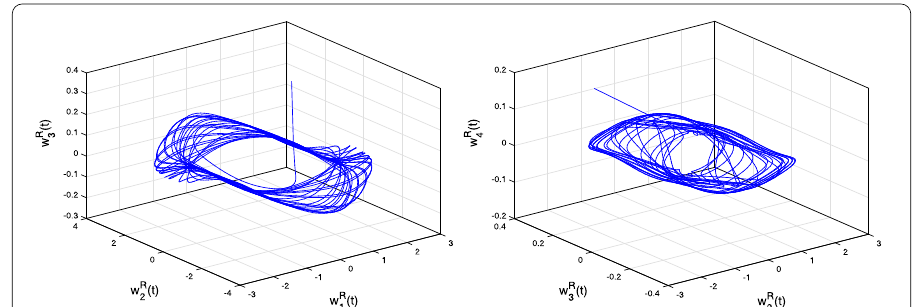
Figure 1 Real part of state variables of FOCVNN